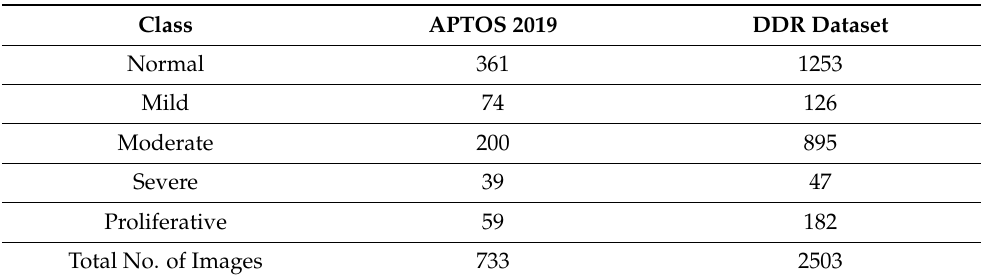
Table 1. Dataset